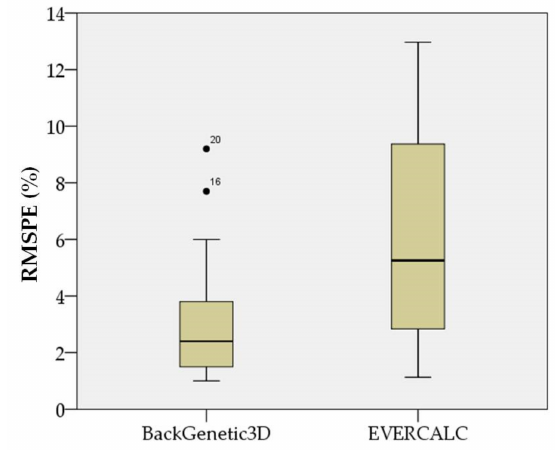
Figure 8. RMSPE for the back-analysis of layer moduli.